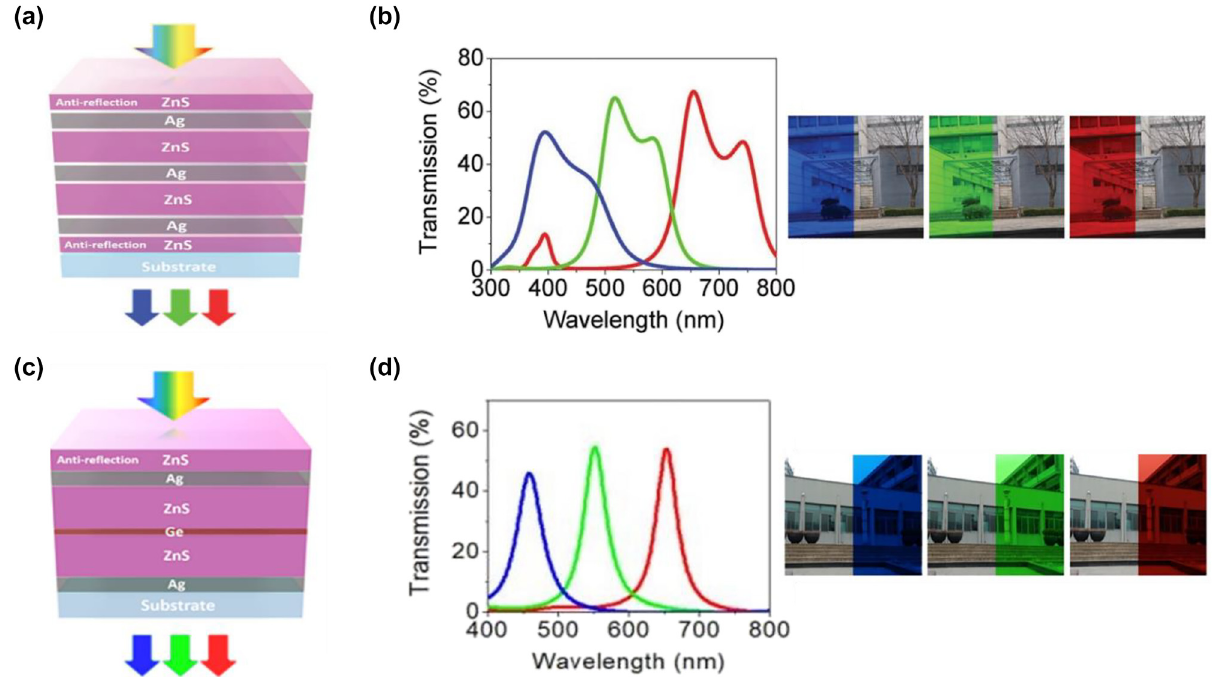
Figure 7: Dual-FP cavity resonance for structural color generation. (a) Schematic representation of the dual-FP cavity with a ZnS antireflection (AR) coating on each side, where each cavity consists of two optically thin Ag films and a ZnS layer. (b) Measured transmission spectra (left panel) and optical images (right panel) of the fabricated samples. For each red (R), green (G), and blue (B) color device, thickness of the ZnS (Ag) layer is chosen as 104 (32), 70 (34), and 40 (28) nm, respectively. For each device, thickness of the ZnS AR coating is set as half of that of the ZnS layer inside the FP cavity. Modified with permission [110]. Copyright 2017, Wiley-VCH. (c) Schematic diagram of transmission-type structural color generation with a dual-FP cavity. (d) Measured transmission spectra (left panel) and optical images (right panel) of the fabricated samples. The thickness of each layer from top to bottom is chosen as 55 nm/30 nm/225 nm/13 nm/30 nm for the red-color device, 45 nm/35 nm/185 nm/5 nm/35 nm for the green-color device, and 35 nm/35 nm/140 nm/5 nm/35 nm for the blue-color device. Modified with permission [76]. Copyright 2019, Nature Publishing